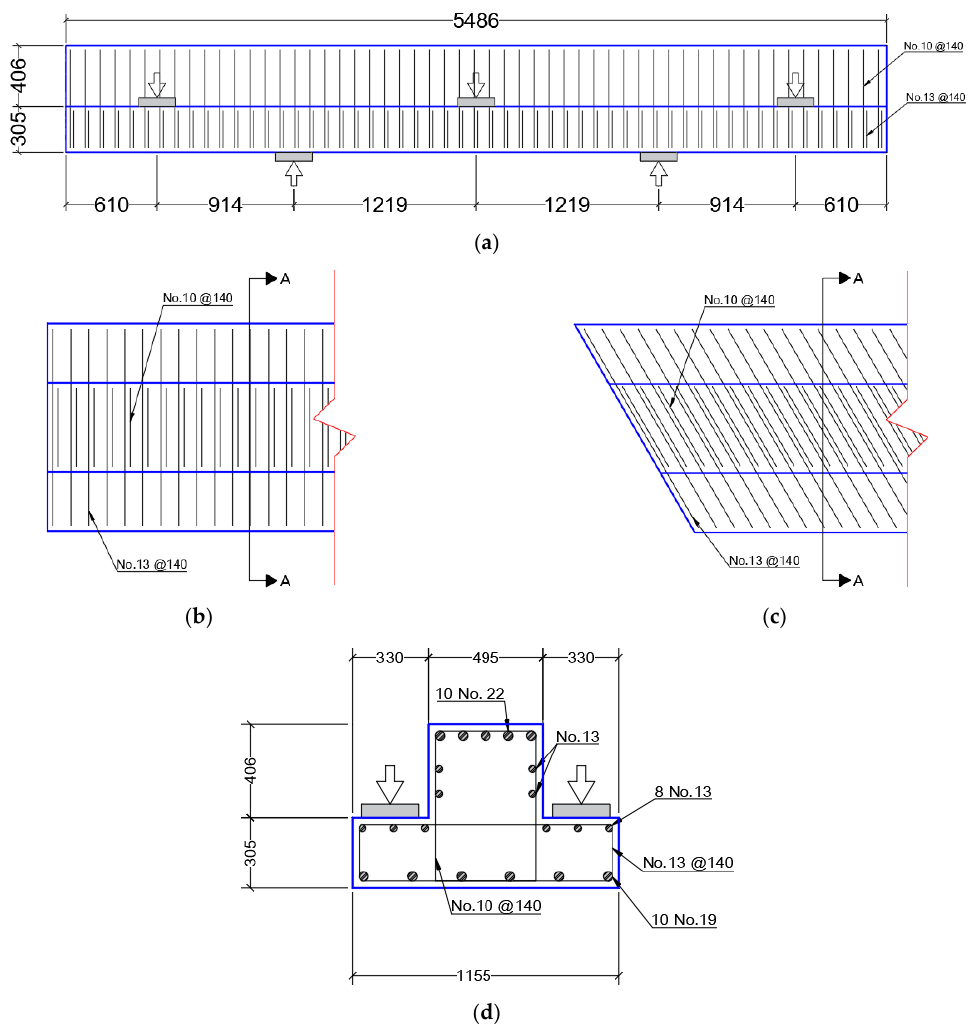
Figure 1. Details of the tested specimens by Roy et al. [14]: ( a ) Details of beam geometry (in mm); ( b ) Transverse reinforcement details for specimen ITBC-0-T-2M; ( c ) Transverse reinforcement details for specimen ITBC-30-S-2M; ( d ) Section A-A (in mm).